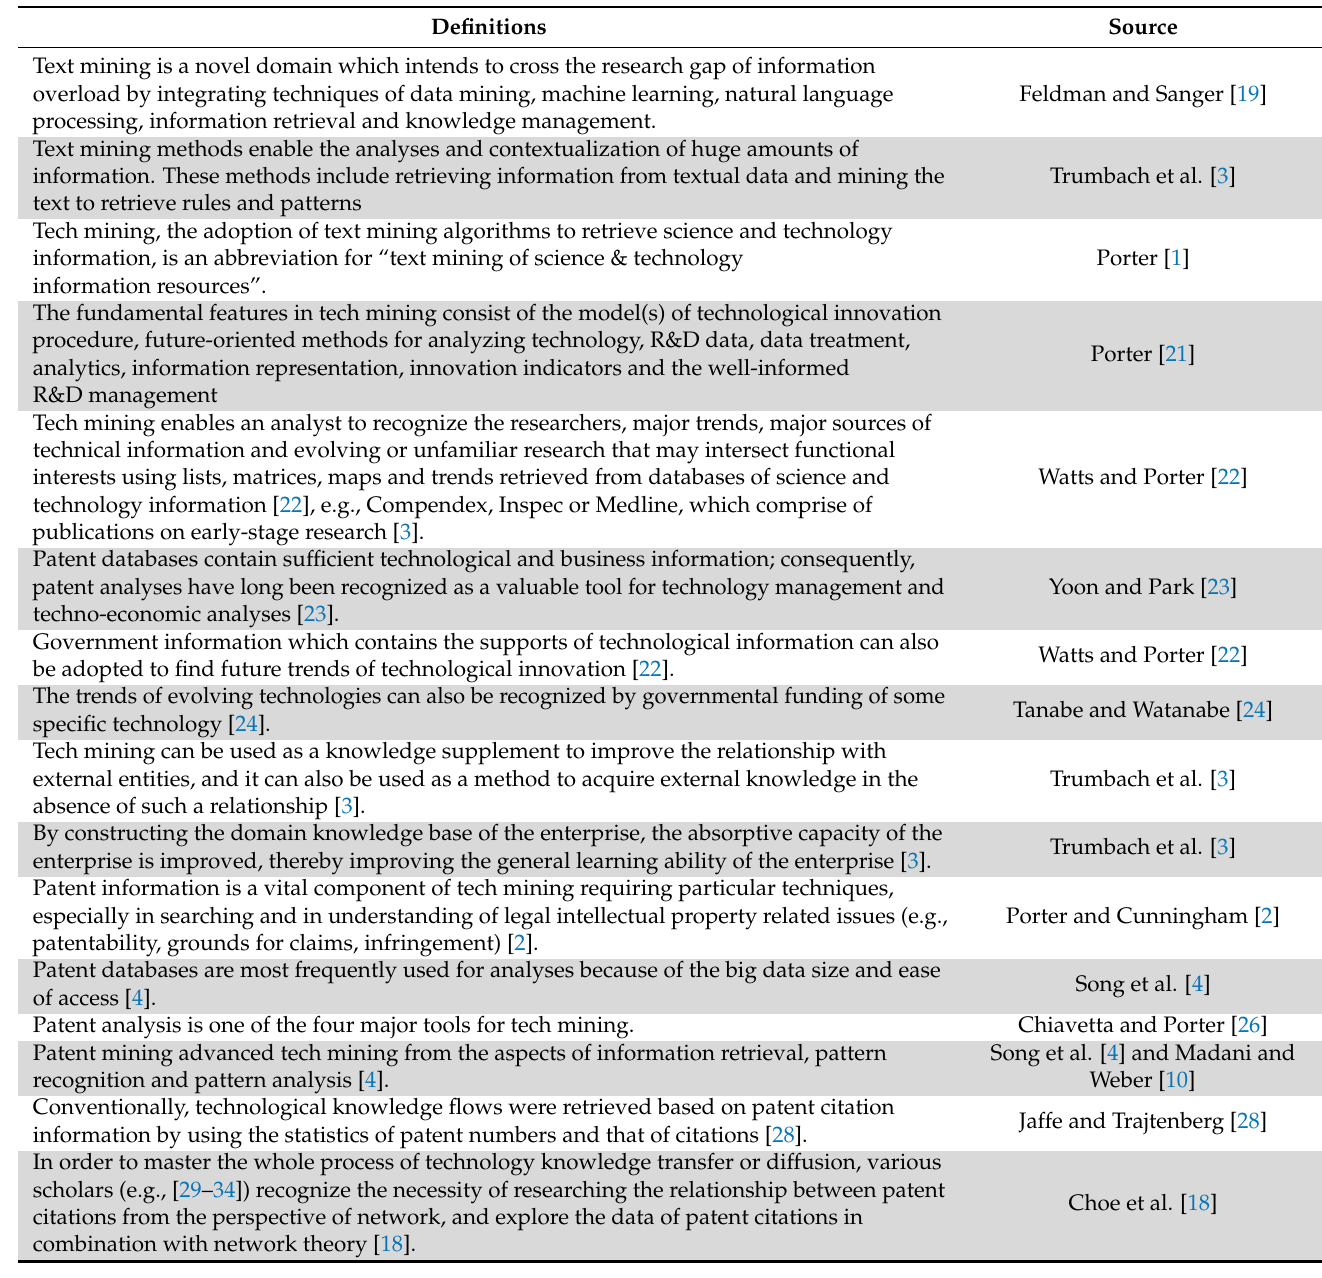
Table 1. A summary of definitions regarding to the mining of text and